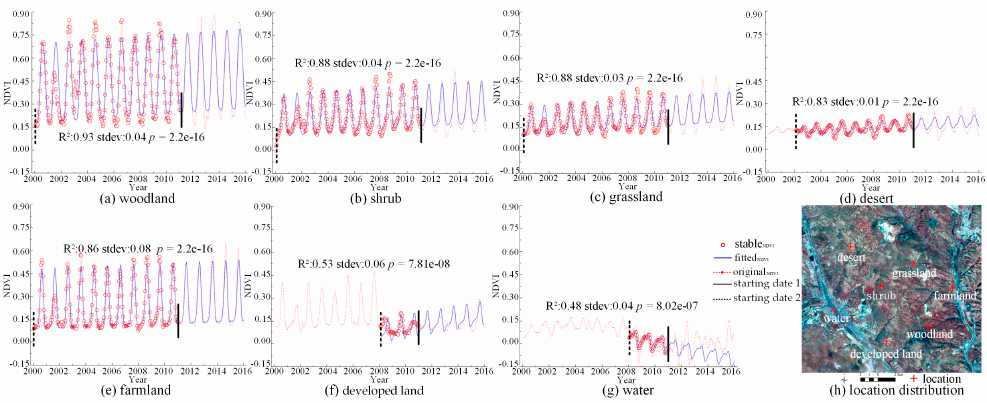
Figure 2. The temporal evolutions of land cover types. R 2 is correlation coefficient, stdev is the standard deviation, p is the significant level, the starting date 1 is the starting date of prediction period, the starting date 2 is the starting date of the stable period. Image in ( h ) is the false color composite (Bands 4, 3, and 2) synthetic SPOT image in 2015.